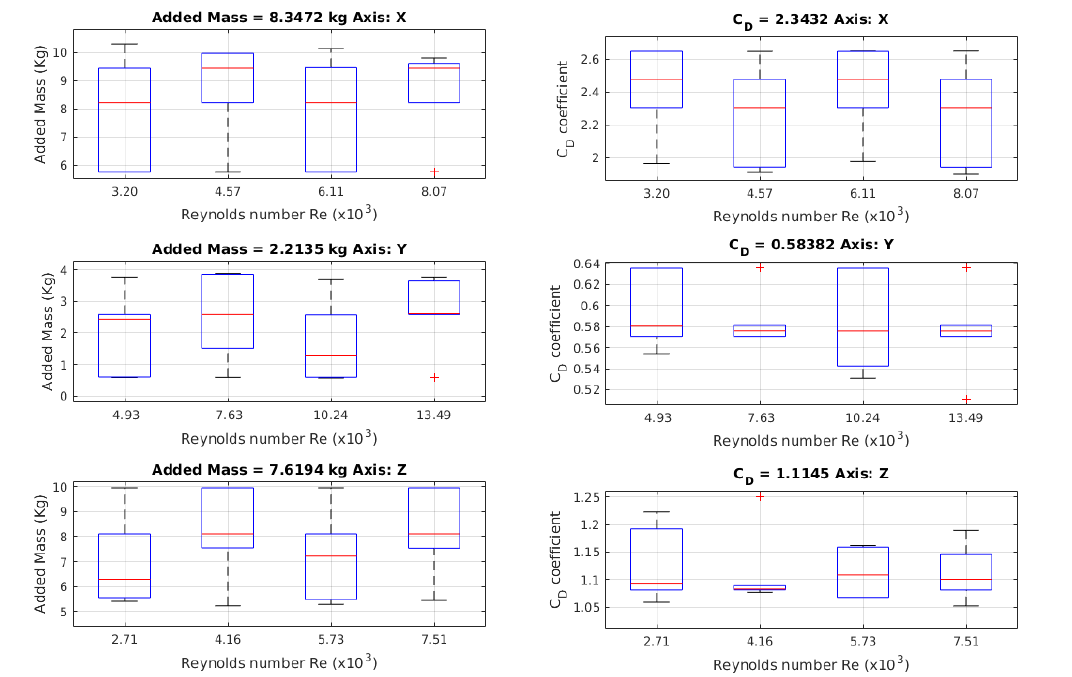
Figure 13. Values for the added mass using the Morison equation for the free decay pendulum test. This is a novel implementation to obtain these values for this kind of